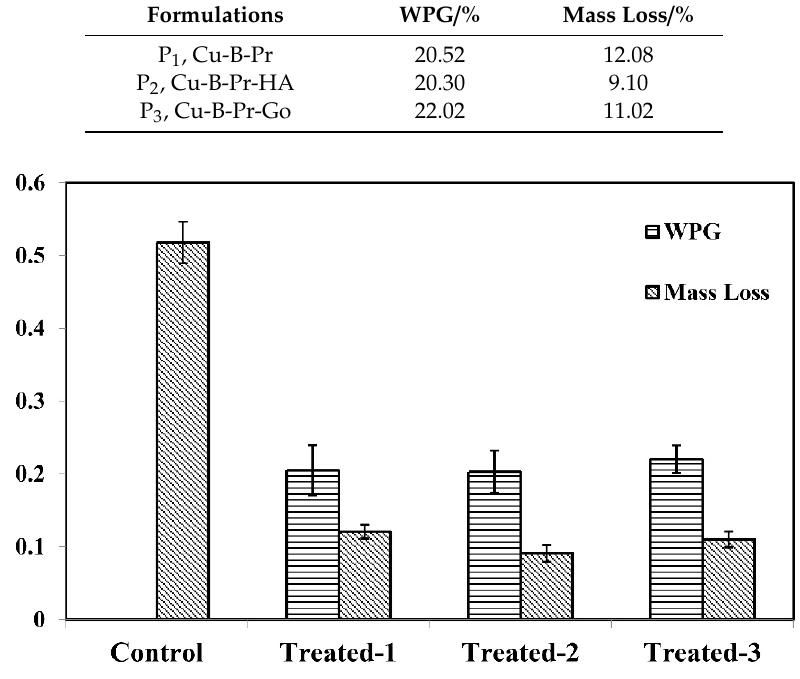
Figure 8. Mass loss and weight percent gain (WPG) control and treated samples.